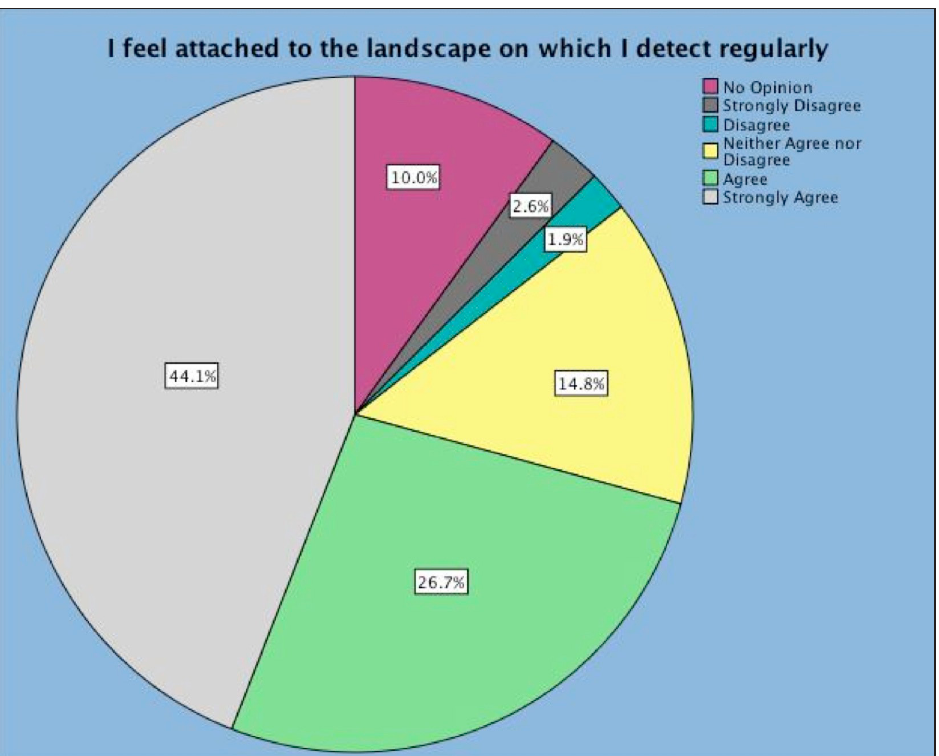
Figure 3: How many respondents agreed with the statement: ‘I feel attached to the landscape on which I detect regularly’ (n =